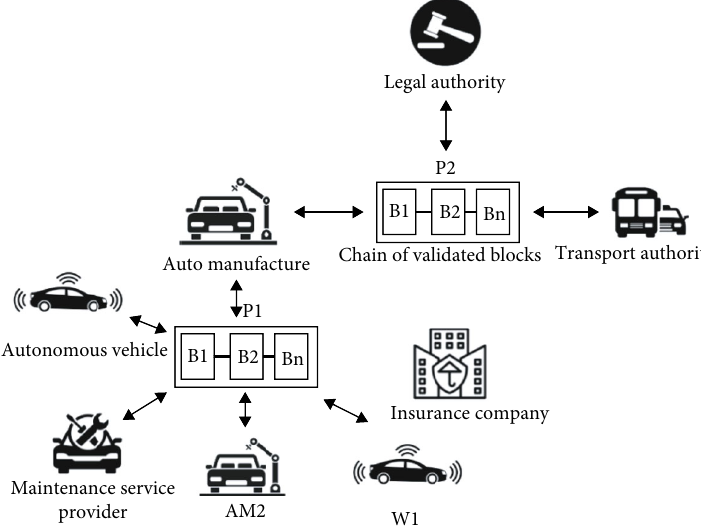
Figure 8: A blockchain-based framework for liability attribution for autonomous